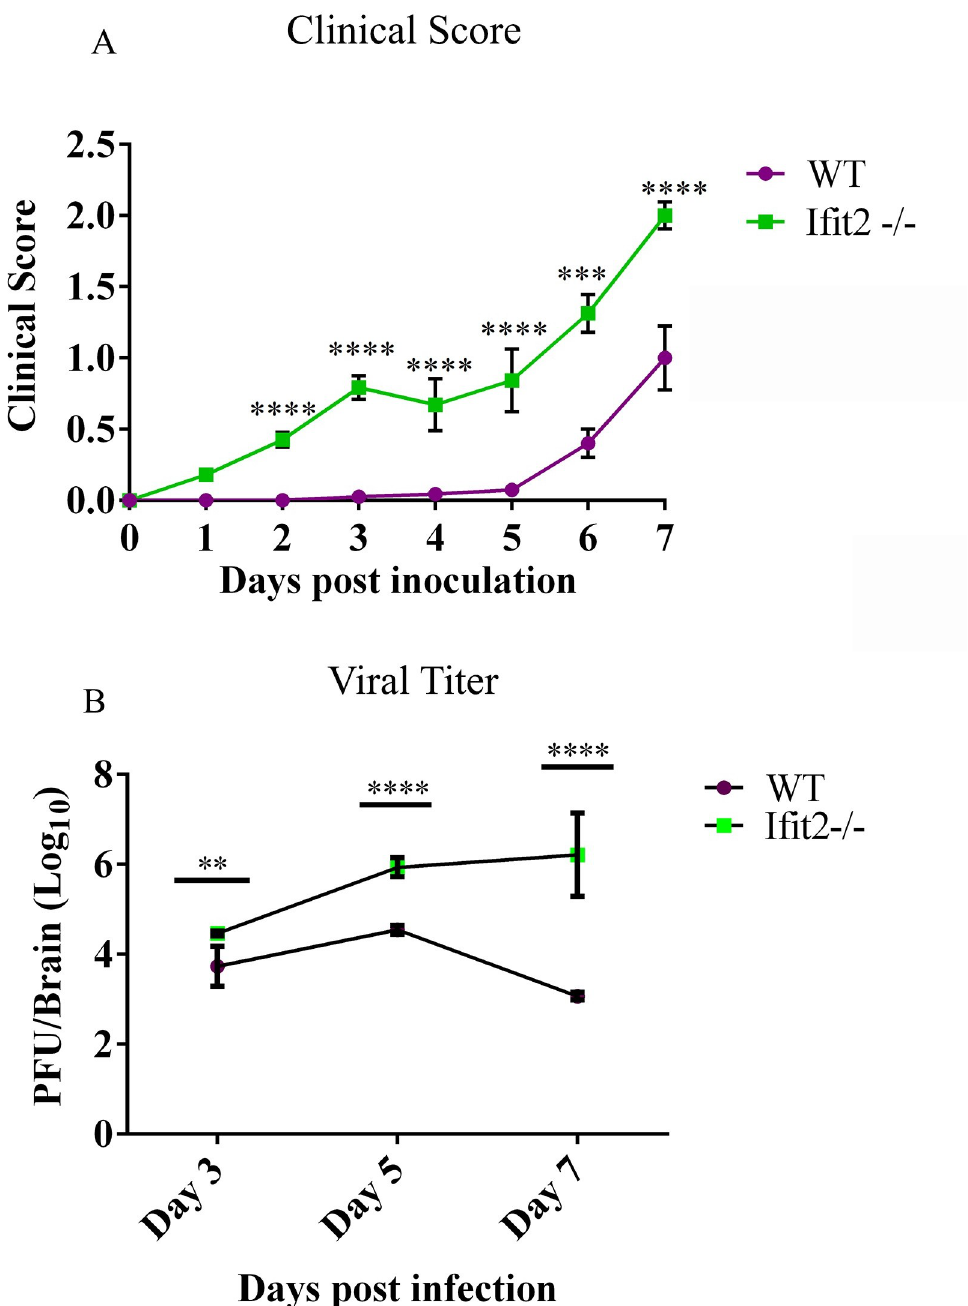
Fig 1. Ifit2 -/- mice showed increased disease severity and increased infectious viral load upon RSA59 infection. : 4–5 weeks old WT (n = 28) and Ifit2 -/- mice (n = 30) were infected intracranially with 2000 PFU of RSA59 and monitored for development of clinical disease (A) and viral titers in brains (B). Clinical scores were assigned by an arbitrary scale of 0–4 as described in Materials and Methods. Viral burden in brain tissue homogenates was analysed by plaque assay and shown as PFU/ brain (approx. 300 mg) from individual mice (n = 5-6/timepoint). The solid line represents the mean viral titer. Asterix ( � ) indicate statistical significance by Two-Way ANOVA analysis for clinical score and unpaired t-test for viral titers. ( �� P < 0.01, ��� P < 0.001, ���� P < 0.0001).